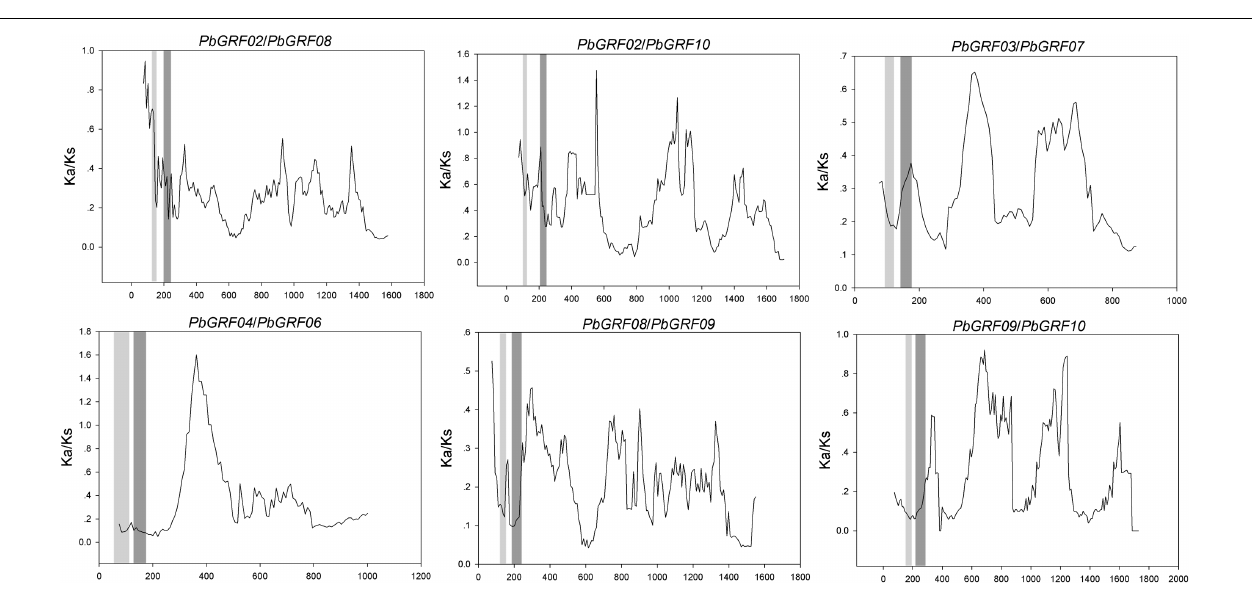
FIGURE 8 | Sliding window plots of duplicated GRF genes in pear. The gray blocks, from light to dark, represent the positions of the WRC and QLQ domains, respectively. The window size is 150 bp, and the step size is 9